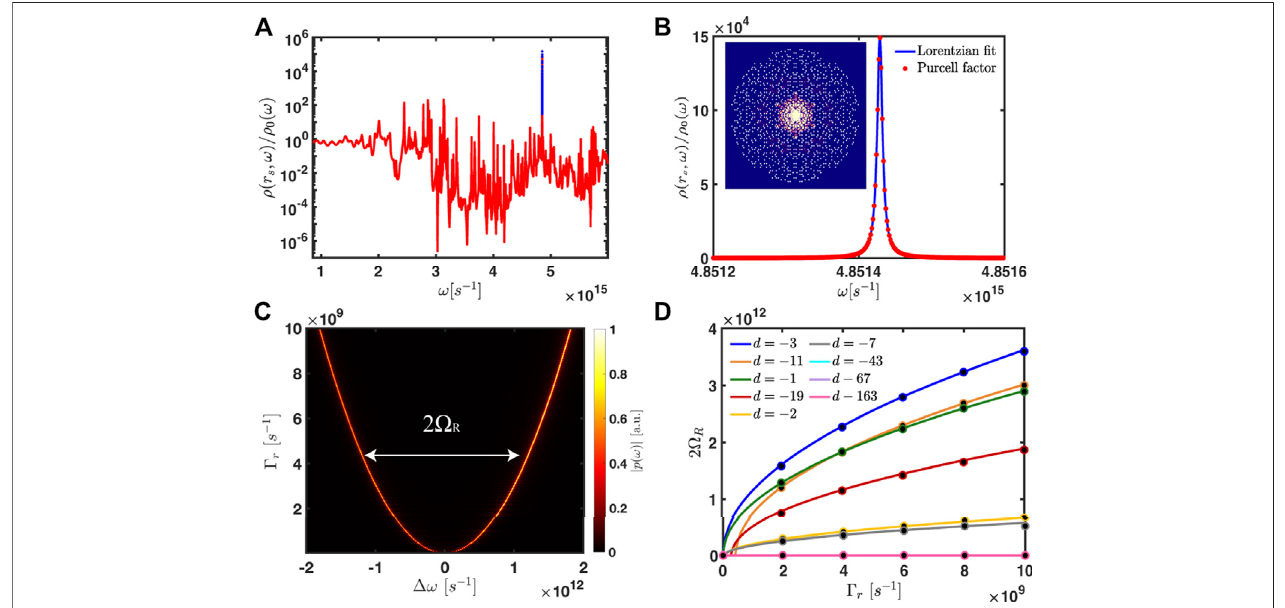
FIGURE 11 | (A) LDOS enhancement/Purcell factor as a function of frequency ω for vertically polarized electric dipoles spatially according to the Eisenstein prime arraysevaluatedatthecenterofthestructure.ThebluemarkersidentifytheopticalmodewiththelargestPurcellenhancementthatis fi ttedbyaLorentzianlineshape,as reportedinpanel (B) .Panel (C) displaysthestrongcouplingbetweenaTLA,positionedatthecenterofthestructure,andtheopticalmodereportedinpanel(b).TheRabi splittingisevaluatednumericallybycalculatingtheabsolutevalueoftheinduceddipolemoment| p ( ω )|oftheTLAasafunctionofthedetunedfrequency Δ ω andthe radiative linewidth Γ r . (D) Rabi splitting 2 Ω R of a TLA coupled with the optical modes with the largest Purcell enhancement factor for each investigated CPA. The continuouslines arethe analyticalpredictions obtainedfrom theanalysis ofthe complexpolesofthe dressed polarizability while themarkers indicate thenumerical